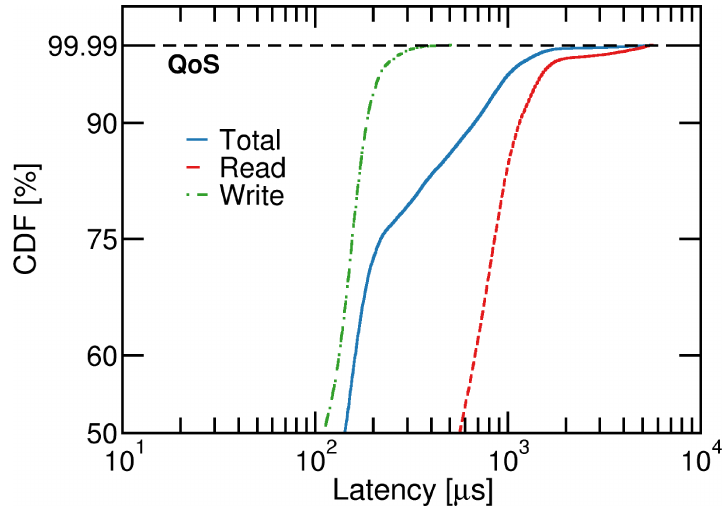
Figure 12. The latency CDF profile of a 75W-25R workload with QD = 64 simulated with the SSDExplorer framework.